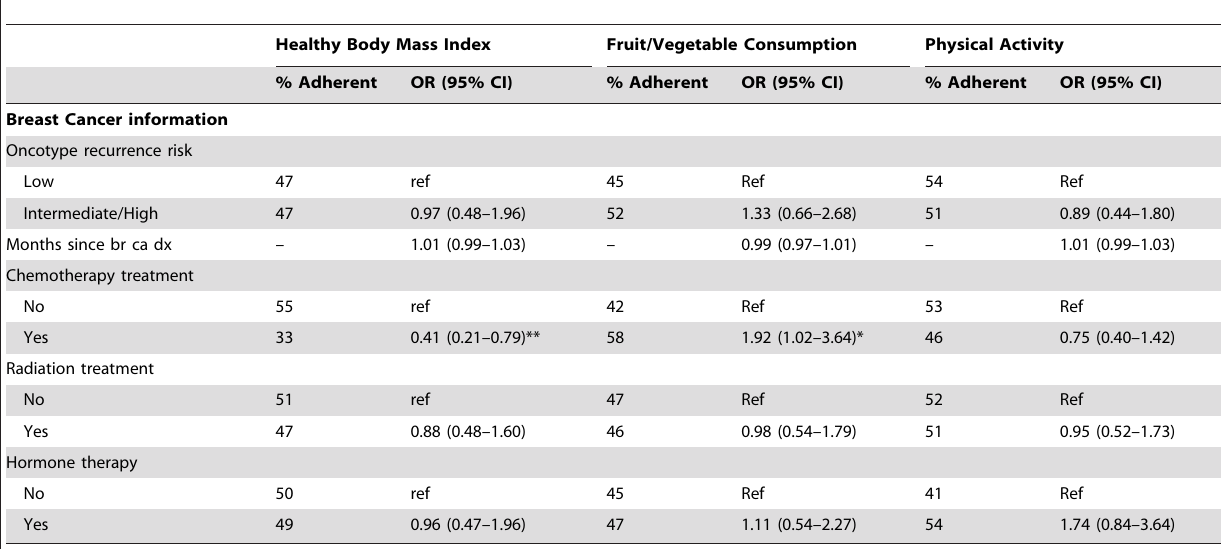
Table 3. Correlates of Meeting Health Behavior Recommendations-Breast cancer information.